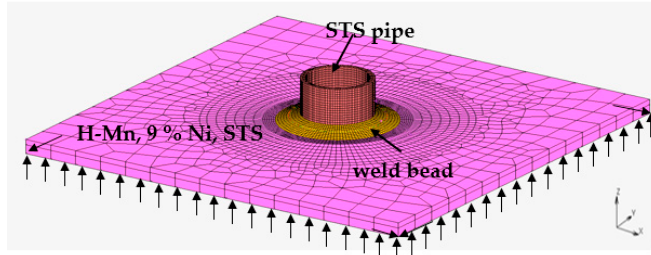
Figure 5. FE-analysis model and boundary conditions.